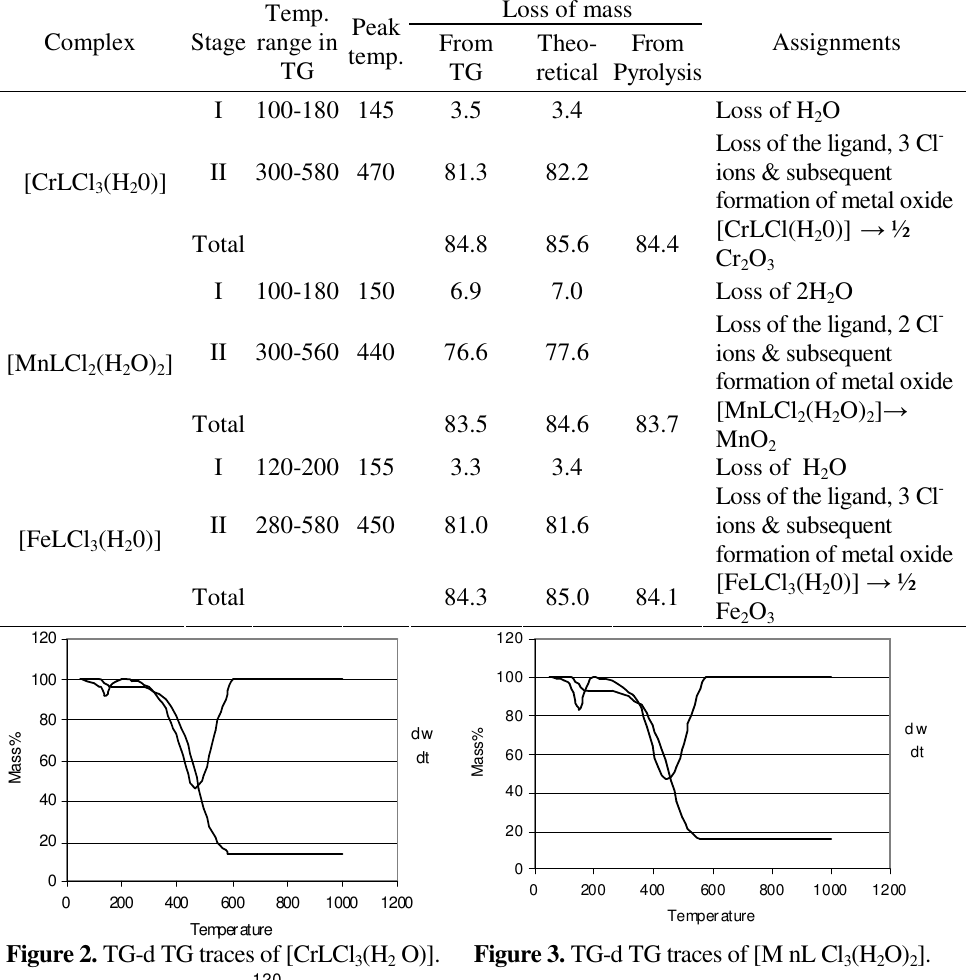
Table 4. Thermal decomposition data of Cr(III), Mn(II) and Fe(III) complexes.